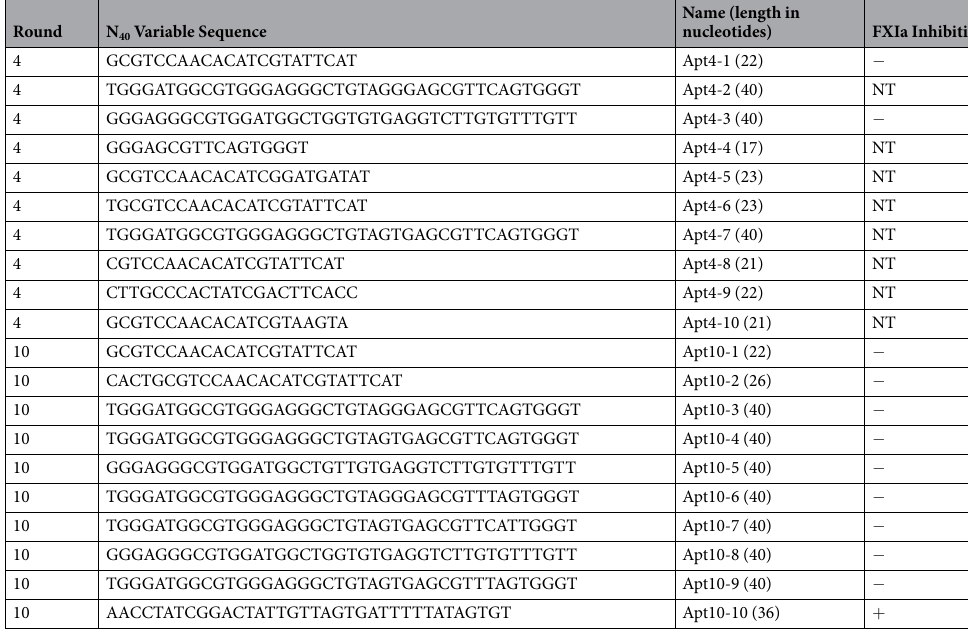
Table 1. High-throughput sequencing and activity screen data. DNA sequence of aptamers (name and length in nucleotides, column 3) isolated after 4 or 10 rounds of screening (column 1) corresponding to the N 40 variable domain in the original aptamer library (5 ′ -GAATTCTAAT ACGACTCACT ATA-N 40 -GCGTCCAACA CATCG-3 ′ ) is given in column 2. Whether ( + ) or not ( − ) the aptamer had inhibitory activity when introduced into FXIa-mediated amidolysis of S2366 is shown in column 4. The ten most abundant sequences obtained after Rounds 4 or 10 are shown in rank order; NT signifies not